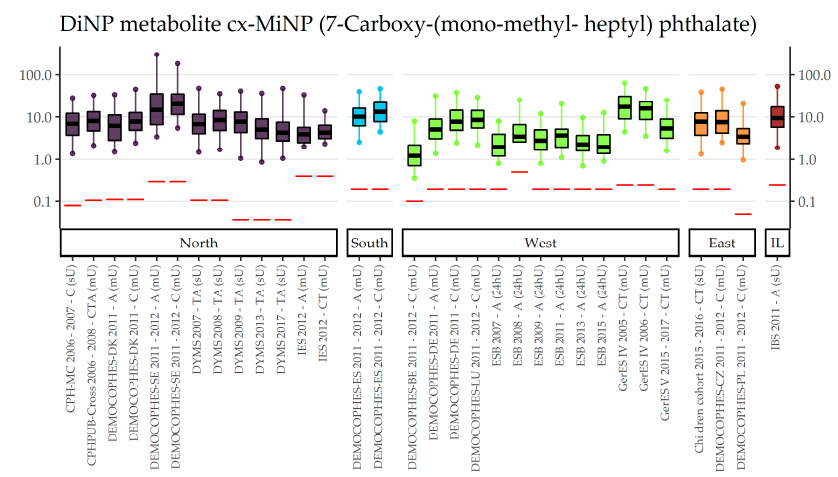
Figure 6. DiNP metabolite cx-MiNP concentration in µ g/L in boxplots. The box is based on P25, P50, and P75, and the whiskers are based on P5 and P95. Boxplots are presented separate by regions (North = violet, South = blue, West = green, East = orange, Israel = dark red); within regions they are chronologically sorted by year of sampling. Red lines denote LOQ/LOD for the respective study. Since percentiles are only available and displayed when they are above LOQ/LOD, the lower side of boxplots might be truncated. The age categories are shown in capital letters: children of the age groups 3–5 and 6–11 (C), adolescents between 12 and 19 years (T) and adults from the age groups 20–39, 40–59 and 60 years and older (A). The sampling method is indicated in brackets: first morning urine void (mU), spot urine (sU) and 24-h urine (24hU).